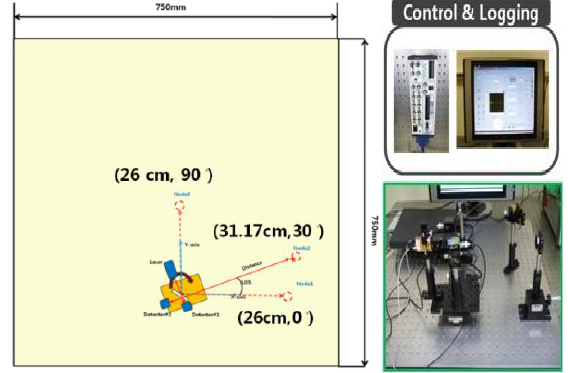
Figure 7. Testbed for the evaluation of the sensor node localization